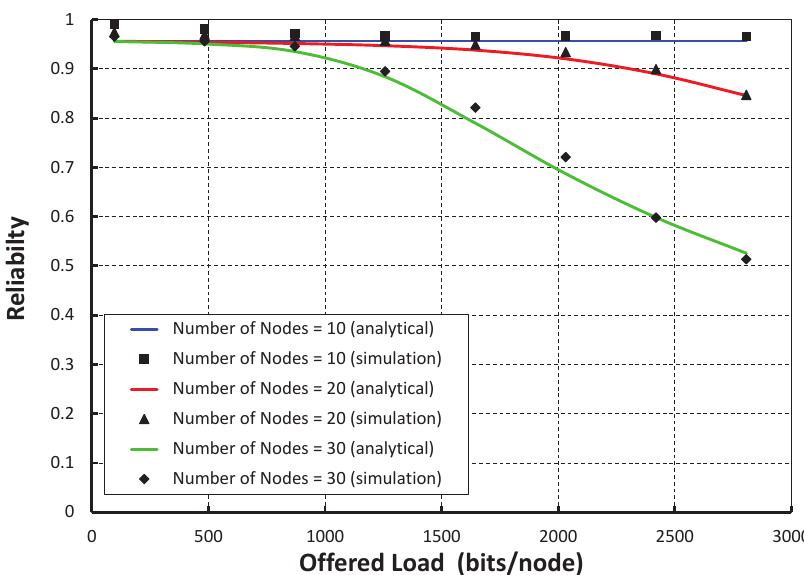
Figure 15. Validation of the reliability for different offered loads.